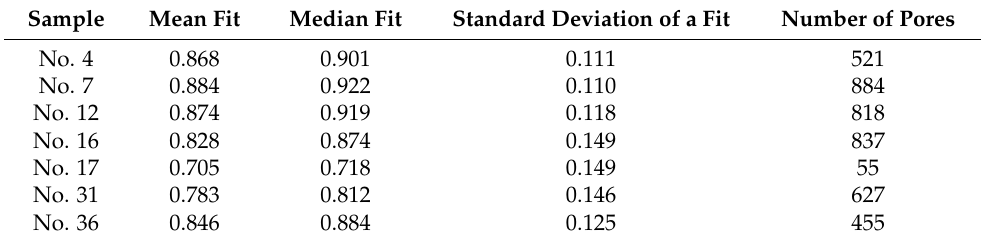
Table 3. Summary of the fitting values for the seven